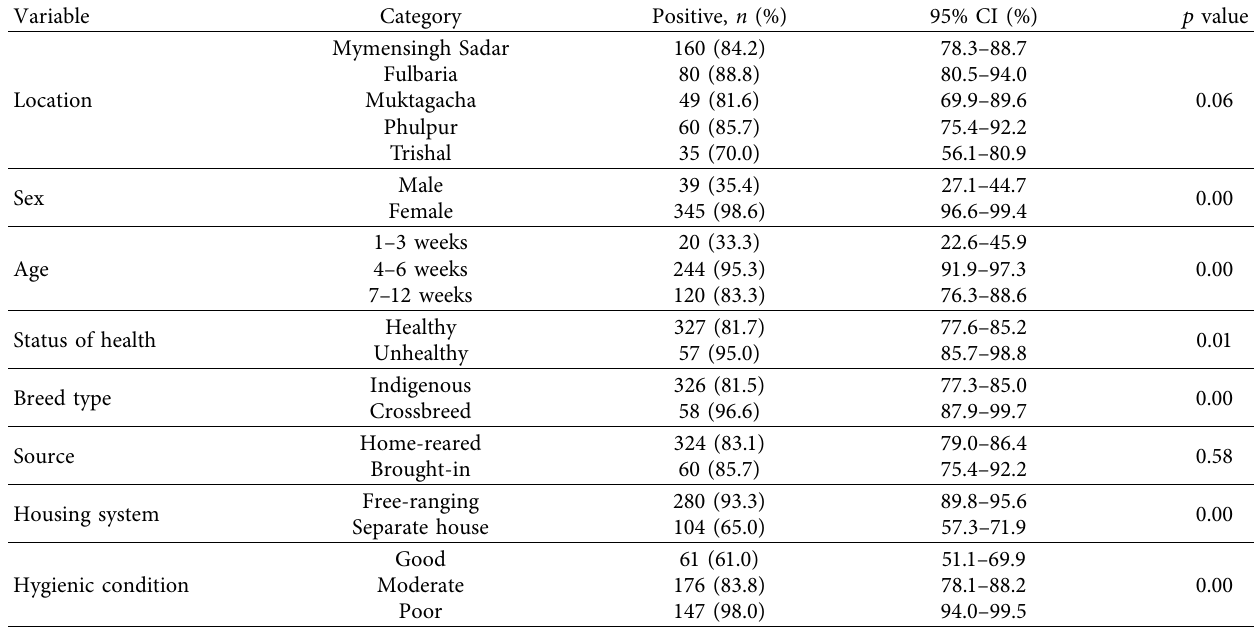
Table 3: Univariate association between seroprevalence of IBDV using ELISA with different factors.